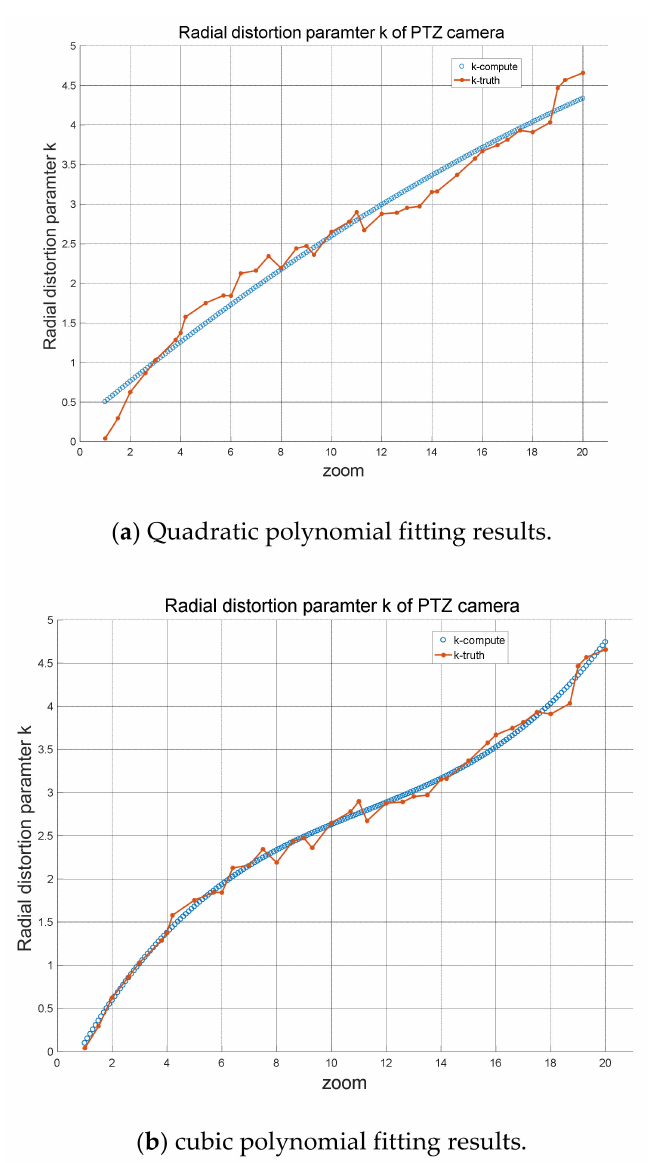
Figure 8. Quadratic ( a ) polynomial and cubic ( b ) polynomial fitting situations. Taking the extrinsic parameters obtained with Zhang’s method as the ground truth and comparing them with the extrinsic parameters calculated using our method, it can be seen from Table 5 that the cosine similarity of the rotation matrix reached more than 99.8%, and the translation vector error was less than 1%. Considering that the PTZ camera remained fixed in its roll direction, we only took the recalculated Euler angles in the horizontal and pitch directions into comparison. The errors are less than 1 degree, which can basically meet the calibration requirements of the extrinsic parameters of dual-PTZ